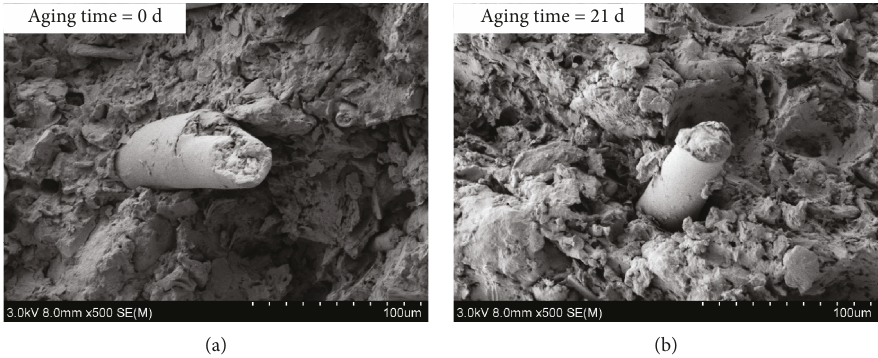
Figure 2: SEM micrographs of the tensile fracture surfaces of the